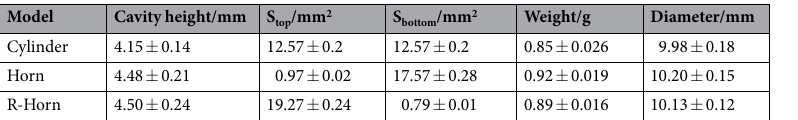
Table 1. Parameters of the 3D printed tablets with Cylinder model, Horn model and R-Horn